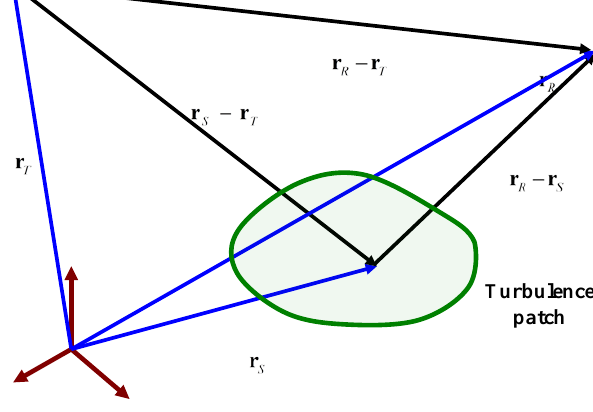
Fig. 1. Scattering geometry at time t 1